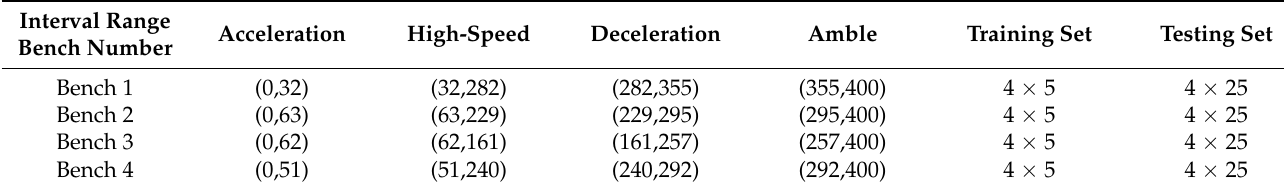
Table 3. Specific interval range and data information of four types of